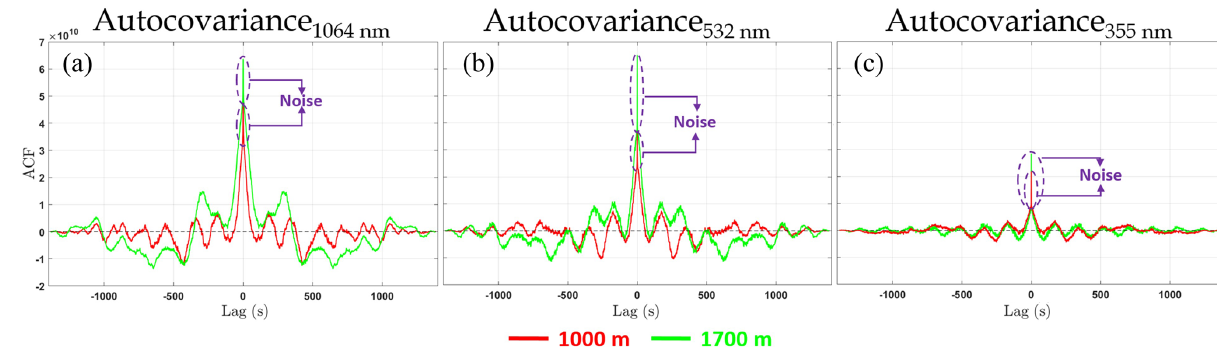
Figure 11. Autocovariance function at 1064 (a) , 532 (b) and 355nm (c) on 19 July 2018 from 18:00 to 19:00UTC.